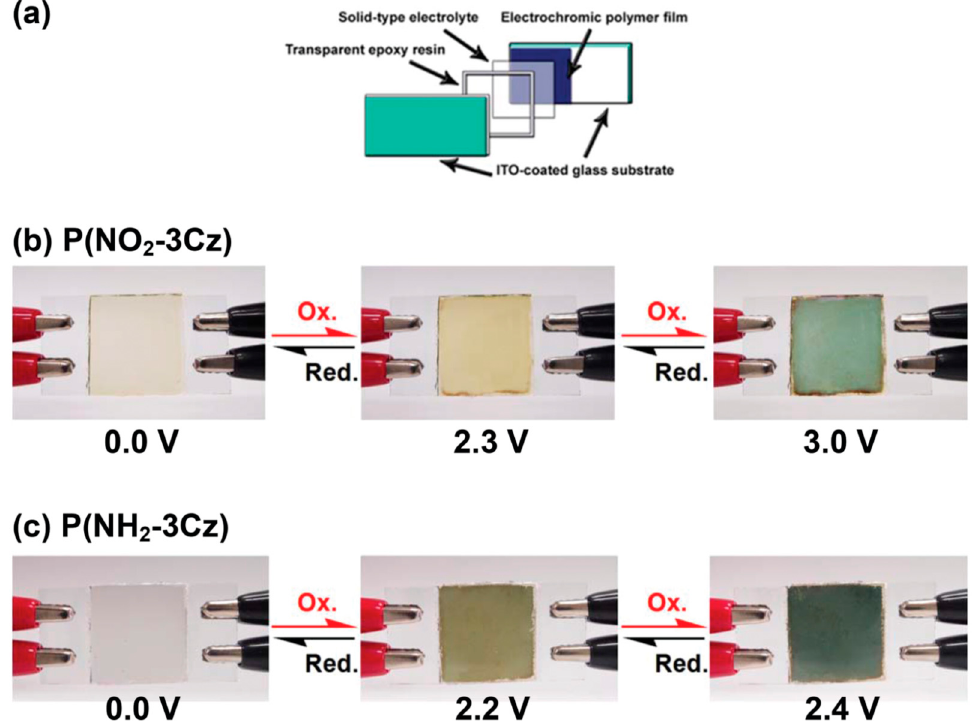
Figure 19. ( a ) Schematic illustration of the structure of the electrochromic devices. Sandwich-type devices, using ( b ) P(NO 2 -3Cz) and ( c ) P(NH 2 -3Cz). Reproduced with permission from [141]. Copyright (2016) Royal Society of